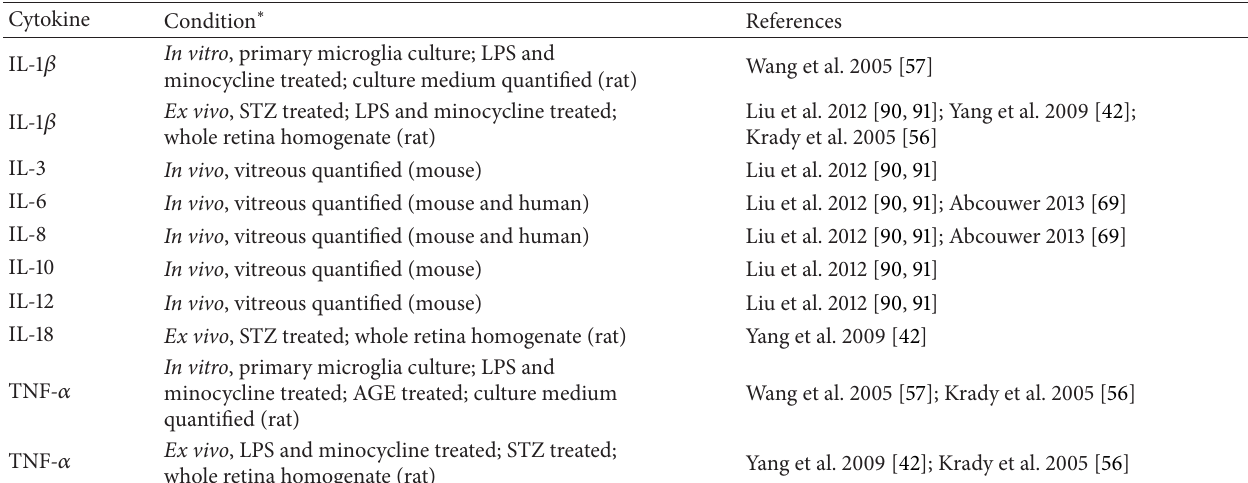
Table 6: Retinal Cell